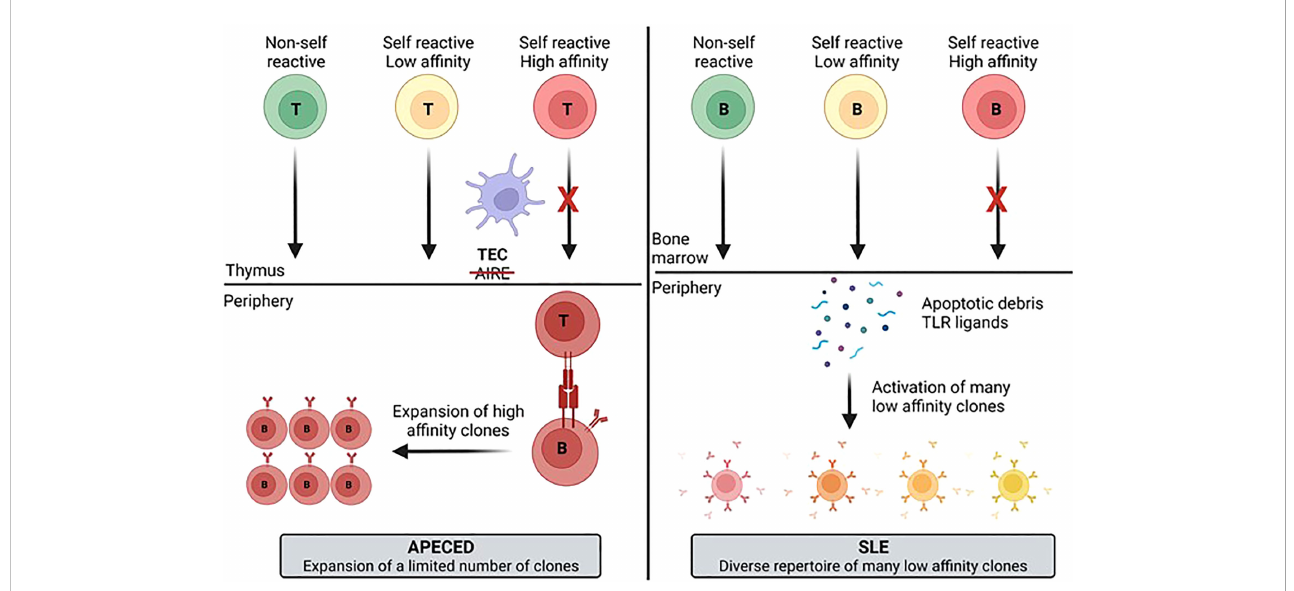
FIGURE 9 Model for development of the autoimmune B-cell repertoire for different diseases. The differences in the diversity and clonotype expansion of the autoimmune repertoire of different diseases may be a function of multiple variables including antigen availability, the presence of PRR ligands that activate B-cells, and T-cell help. These different factors likely contribute to generation of a more focused and clonally expanded repertoire in APECED patients and a more diverse, but less expanded repertoire in SLE patients. APECED, autoimmune polyendocrinopathy – candidiasis – ecto-dermal dystrophy; PRR, pattern recognition receptor; SLE, systemic lupus